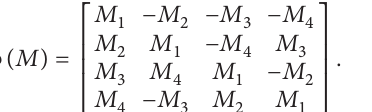
Algorithm 7 (Iterative algorithm for Problem